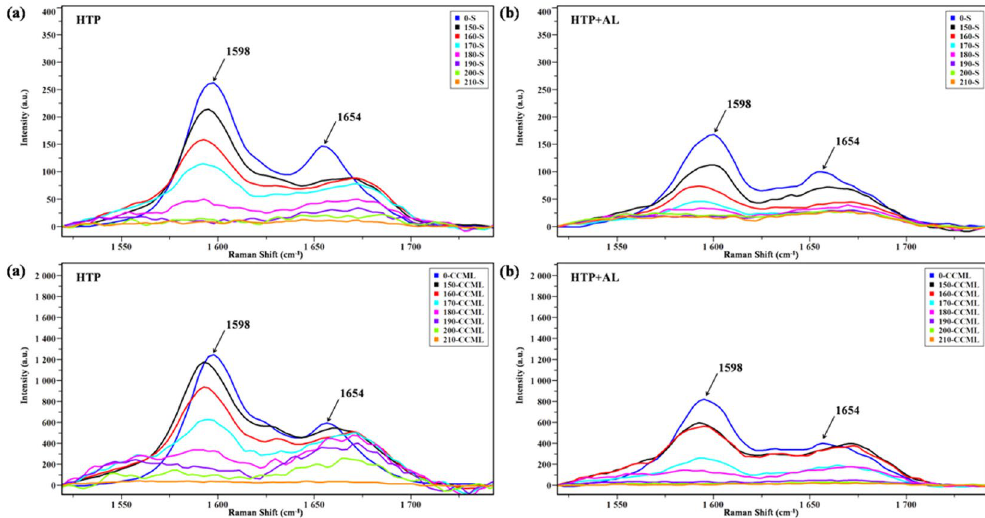
Figure 3. Zoom into average Raman spectra obtained from the secondary wall and CCML regions of Eucalyptus cell walls at different pretreatment conditions ( a ), hydrothermal pretreatment; ( b ), hydrothermal pretreatment followed by alkaline pretreatment, 1520–1742 cm − 1 . S, secondary cell wall; CCML, cell corner middle